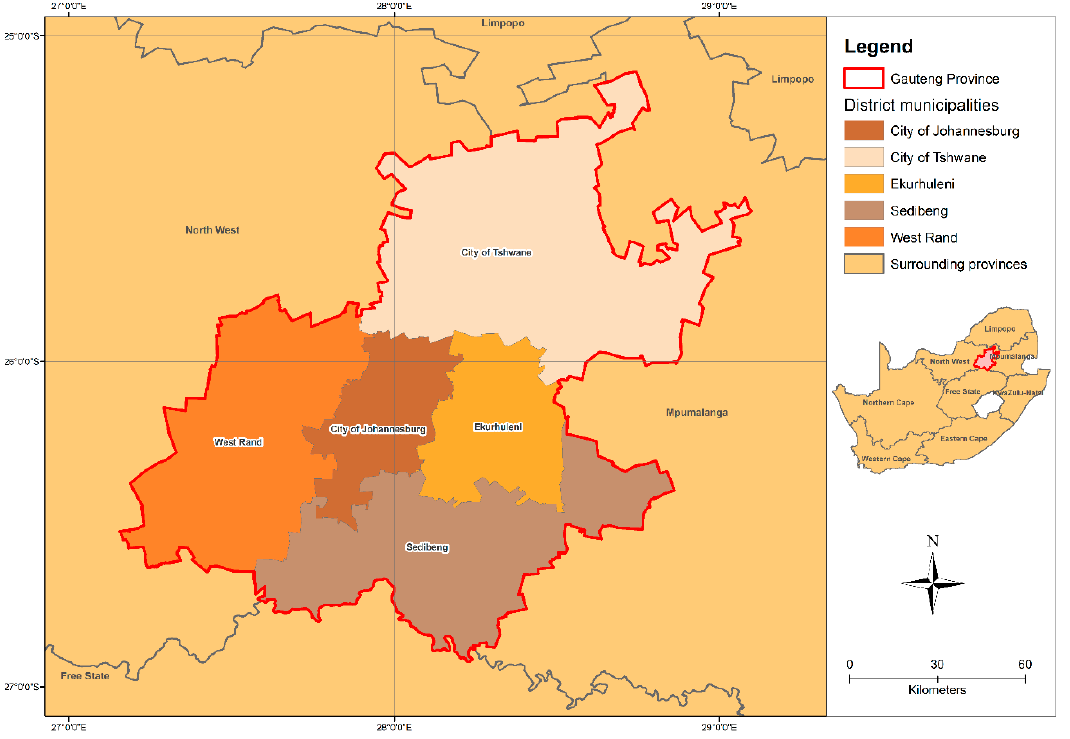
Figure 1. Map of Gauteng Province and its five municipalities (Source: Thandi Kapwata, South African Medical Research Council).